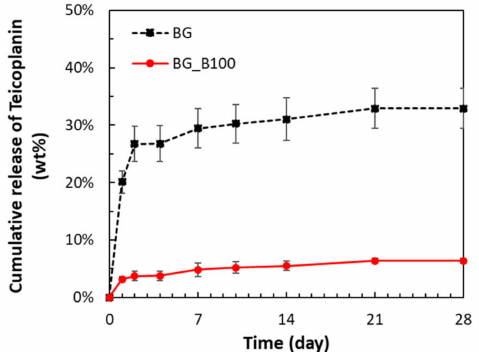
Figure 5. Cumulative release of teicoplanin from BG and B-doped BG